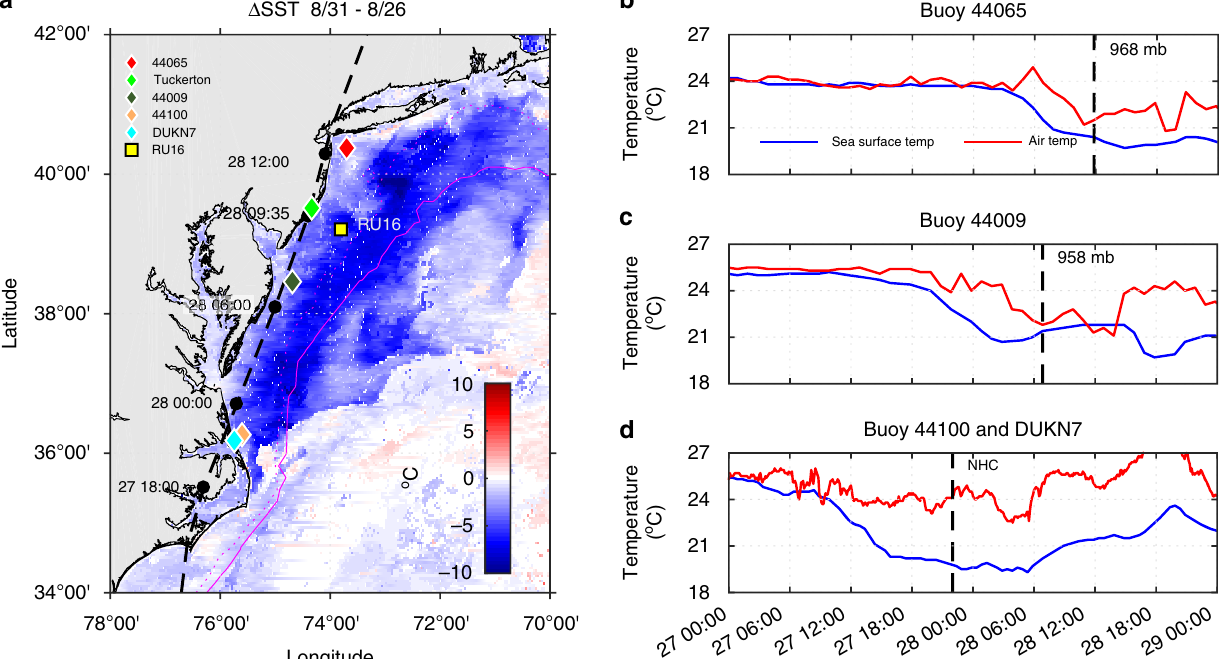
Figure 1 | Map of the study domain with satellite and buoy data. ( a ) SSTdifference map post-Irene (8/31) minus pre-Irene (8/26) with NHC best track (black dots connected by dashed line labelled with August date and UTC time), weather buoys/stations (coloured diamonds), underwater glider RU16 location during storm (yellow square) and bathymetry at 50m (dotted magenta) and 200m (solid magenta). ( b – d ) Buoy/station observed SST (blue) and air temperature (red) with vertical black dashed line/label indicating the time/value of minimum air pressure ( b , c ), and time of eye passage according to NHC best track data ( d ). The individual SST three-day composite maps for 24–26 August and 29–31 August are provided in Supplementary Fig.